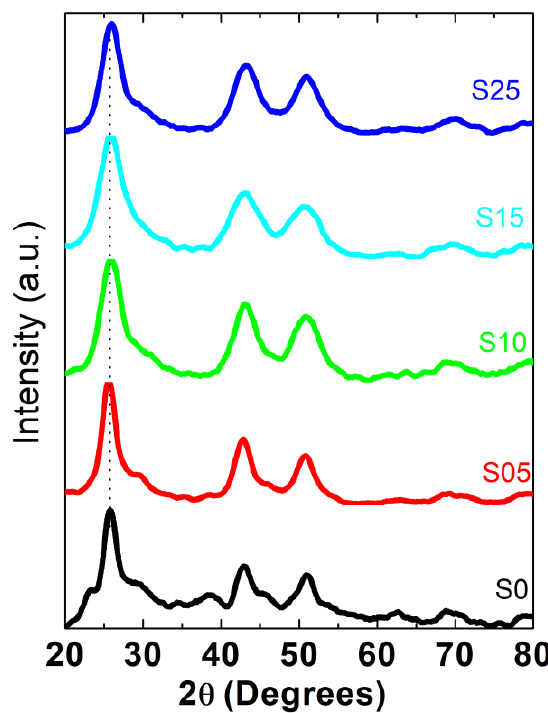
Figure 2. X-ray diffraction patterns of the CdSSe alloy crystal with different percentages of sulfur.